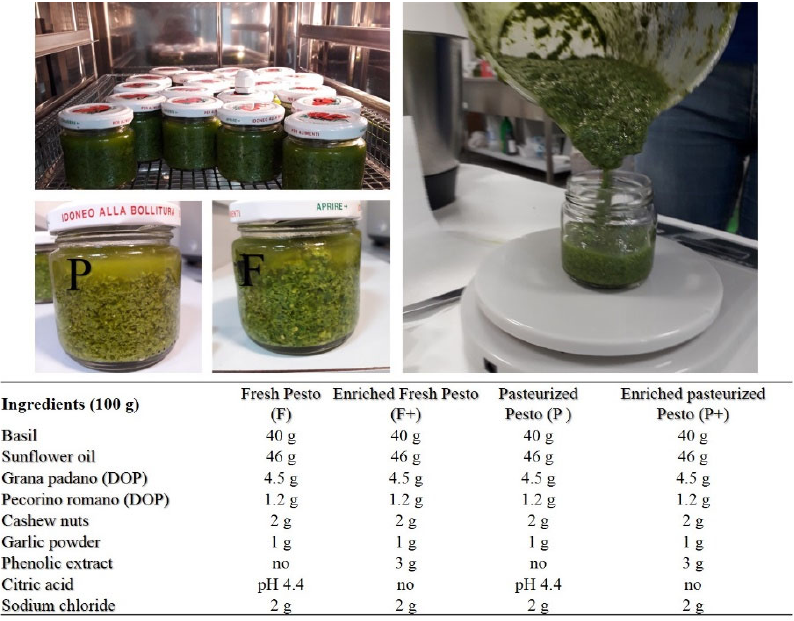
Figure 1. Basil pesto